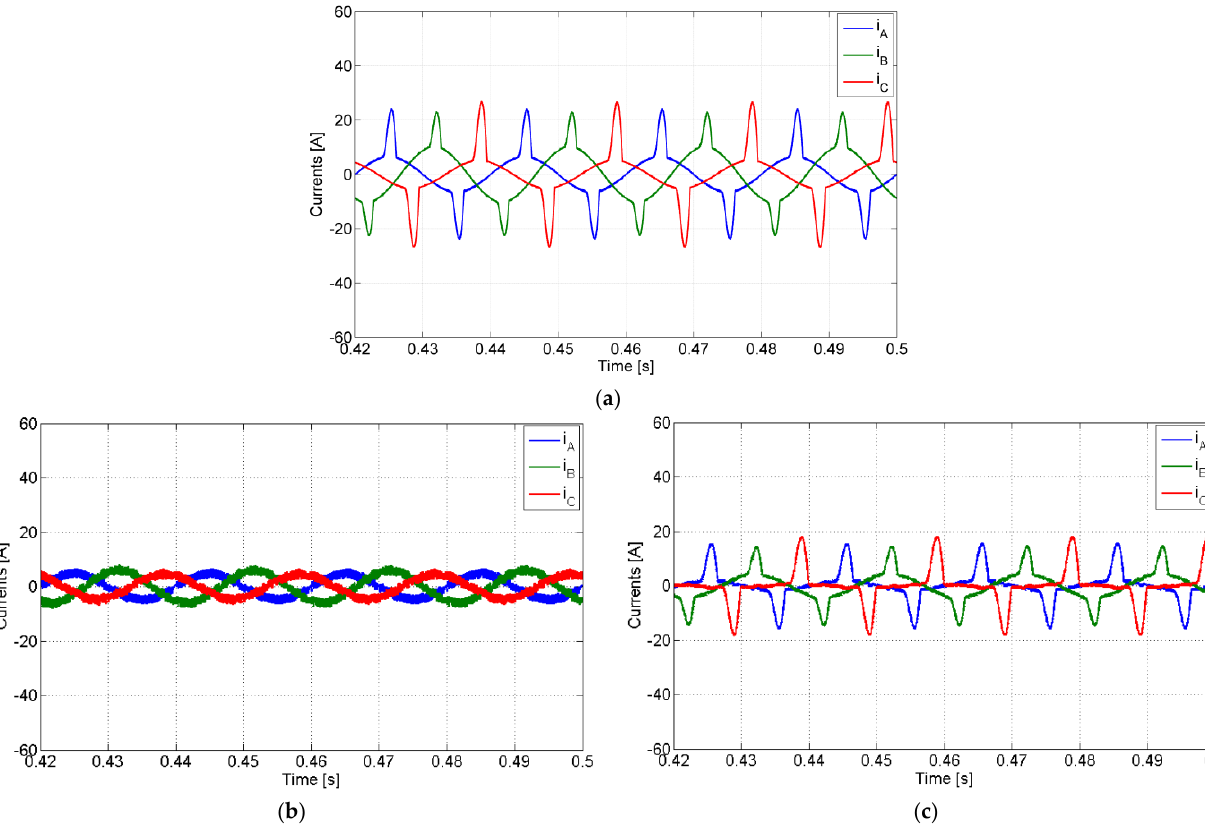
Figure 17. Simulation results with the PV generator in subcompensation mode with a non-linear load and compensation of the active power imbalance: ( a ) AC currents of the PV generator; ( b ) load currents; ( c ) grid currents.